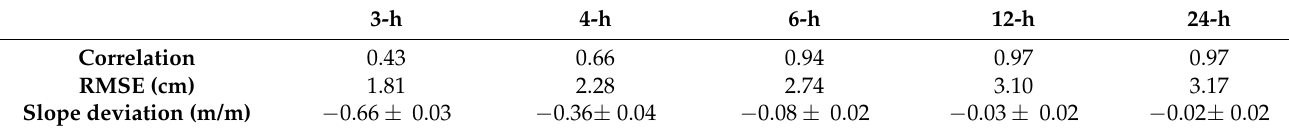
Table 1. Statistics of OTT RLS records and GNSS-R sea level retrievals for each band.